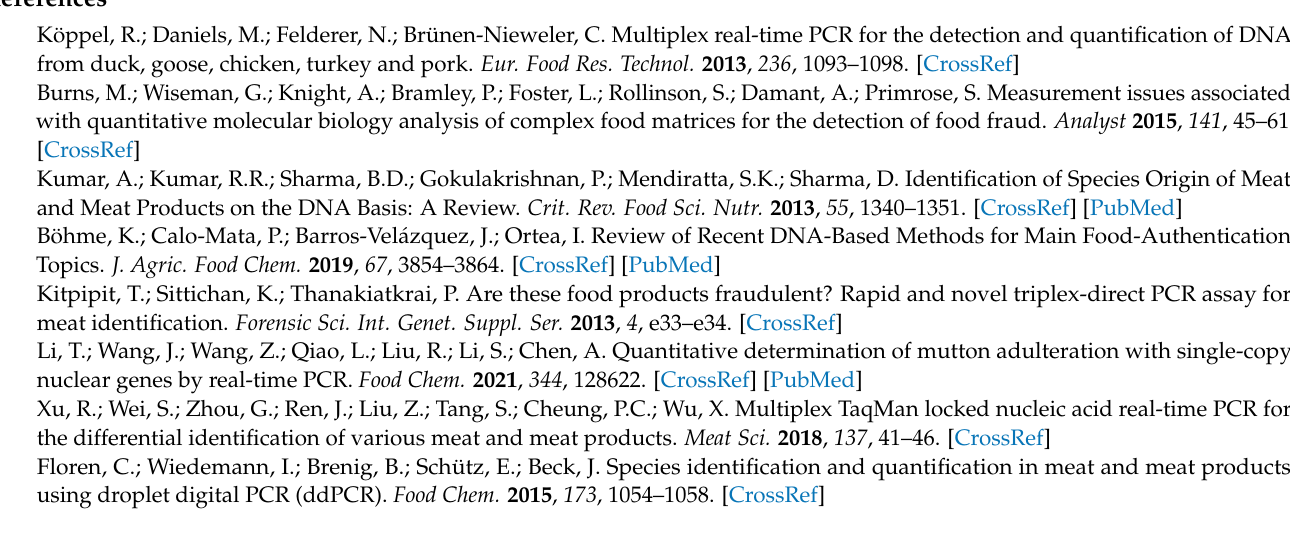
standard. Table S3: Raw data of the homogeneity analysis. Table S4: Results of the short-term stability study. Table S5: Results of the long-term stability study. Table S6: Results of independent laboratory